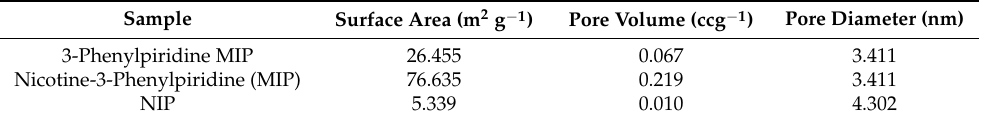
Table 2. Summary of BJH desorption result.